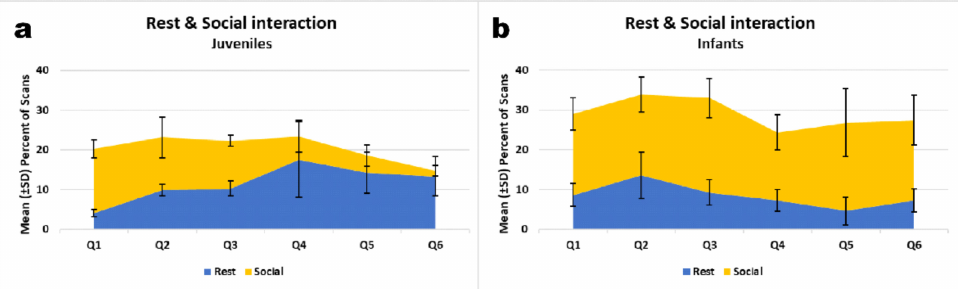
Figure 4. Mean proportion of activity budget spent on resting and social interaction for juveniles ( a ) and infants ( b ): Trends per rehabilitants over 6 quarters. Same data base as in Figure 3.